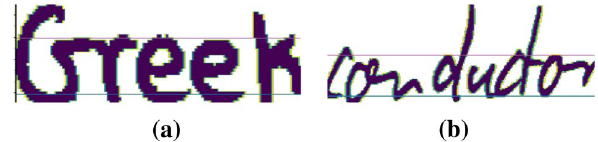
Fig. 2 Two examples of word images where estimated upper (pur- ple colored line) and lower (green colored line) boundaries of dense regions are